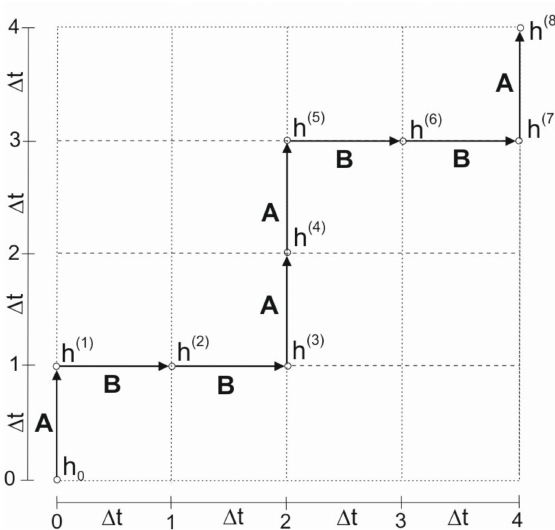
Figure 4. Schematic sketch of an alternate splitting method (Equations (29)–(35)) for t = 4 ∆